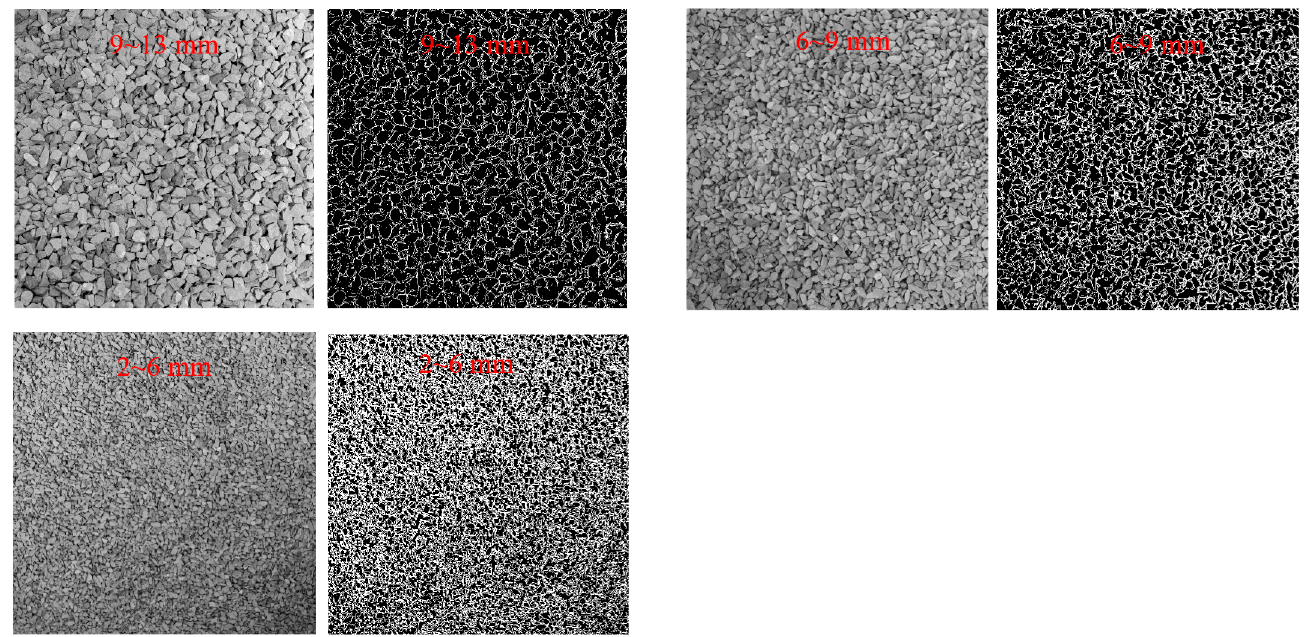
Figure 8. Images of different coal particle sizes.